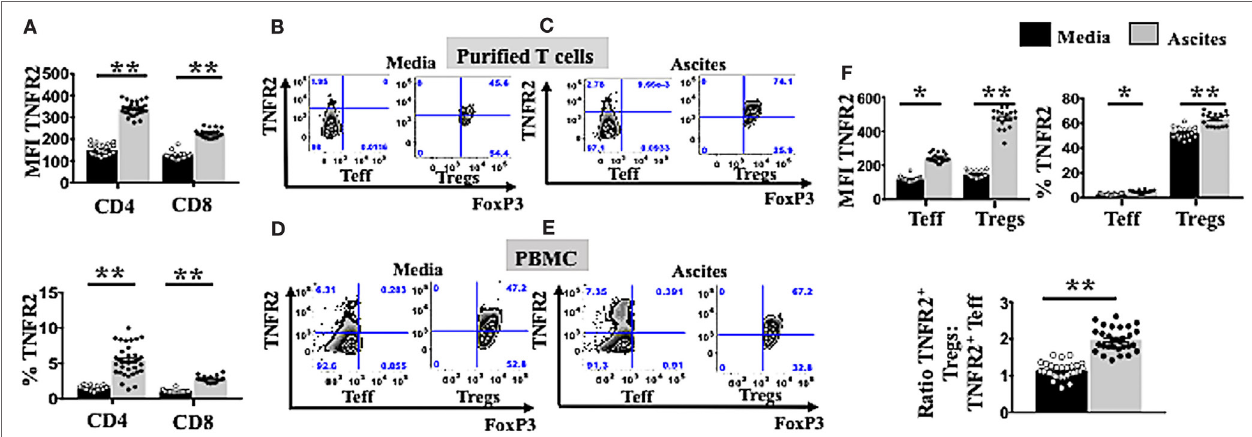
FigUre 2 | Ascites upregulates tumor necrosis factor receptor 2 (TNFR2) expression on both T effector (Teff) and regulatory T cells (Tregs). (a) Peripheral blood mononuclear cells (PBMCs) from healthy donors ( n = 30) were isolated by Ficoll density centrifugation and incubated in vitro in either AIM V media or cell-free ascites from advanced epithelial ovarian cancer (EOC) patients for 48 h. Cells were washed, stained with anti-CD3, CD4, and CD8 and TNFR2 and analyzed with flow cytomcery (a) . The level of TNFR2 expression (median fluorescence intensity, MFI) and frequency (%) of TNFR2 within CD4 + and CD8 + T cells in media (black bar) and ascites (gray bar) ( n = 30) (B,c) . PBMCs from two healthy donors were isolated by Ficoll density centrifugation. Cells were labelled anti-CD3, anti-CD4, anti-CD25, and anti-CD127 and flow cytometric cell sorting for Tregs and Teff was performed. Isolated Tregs and Teff were cultured in either complete AIM V media or in cell-free ascites for 48 h. Cells were then washed and labeled for surface markers with CD3, CD4, CD25, and TNFR2 followed by intracellular staining for FoxP3 and prepared for flow cytometric analysis (B,c) . Representative flow cytometry expression of TNFR2 and FoxP3 on sorted Tregs and Teff cells as well incubated in media (B) and ascites (c) . (D–F) PBMCs from a single healthy donor were incubated in vitro for 48 h in either AIM V media or cell-free ascites from 18 patients with advanced EOC ( n = 18). Cells were washed, stained with CD3, CD4, CD25, TNFR2, and FoxP3, and analyzed with flow cytometry. (D,e) Expression of TNFR2 and FoxP3 was analyzed with flow cytometry by gating on Tregs and Teff cells derived from PBMCs incubated in media and ascites. (F) The level of TNFR2 expression (MFI) within Teff and Tregs and percentages (%) of TNFR2 + Teff and Tregs and the ratio of TNFR2 + Tregs to TNFR2 + Teff in media and ascites ( n = 18). * p < 0.05 and ** p < 0.0001, Wilcoxon matched-pair t -test. Data from PBMCs were pooled from three independent experiments (error bars-SEM), while data of sorted cells are replicates of two